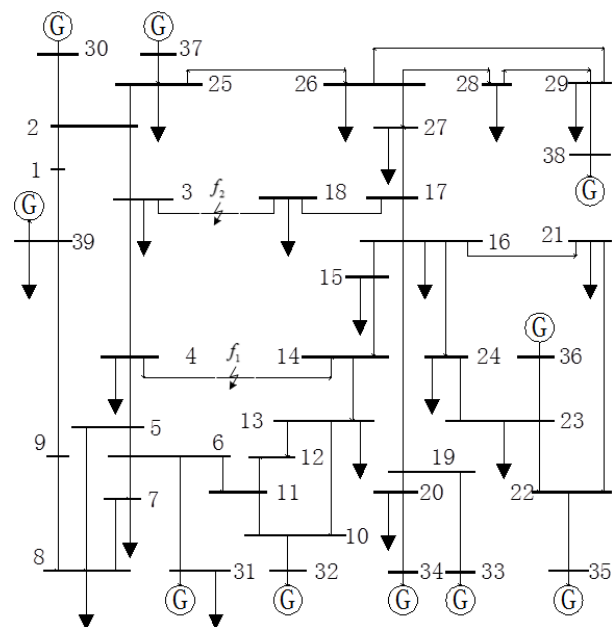
Figure 6. The diagram of IEEE 10 ‐ unit 39 ‐ bus power system.